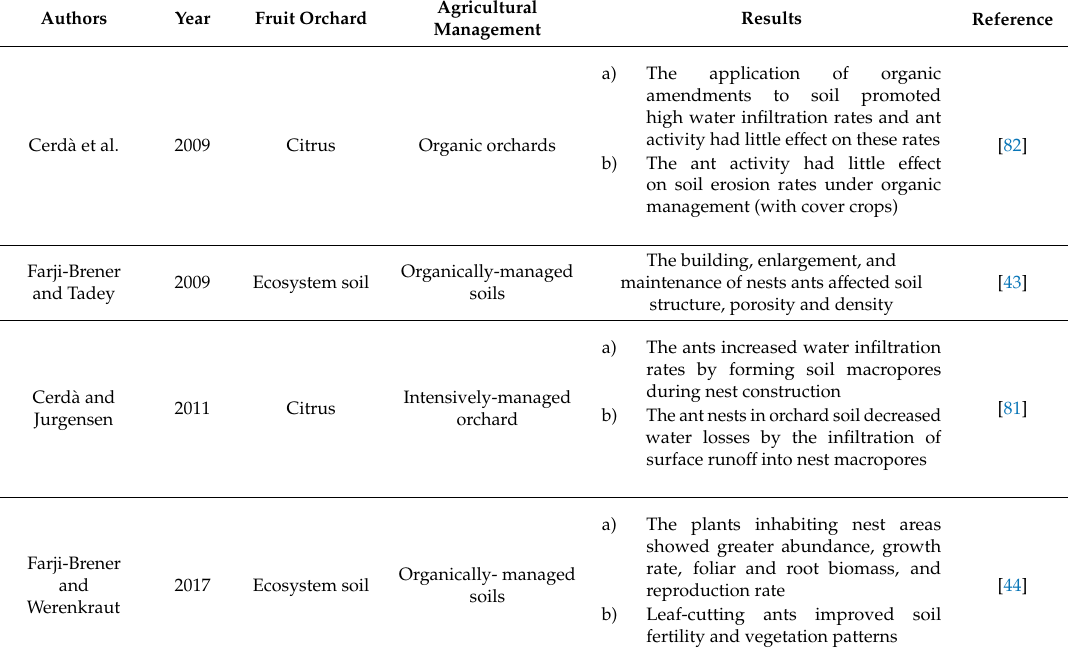
Table 2. E ff ects of di ff erential agricultural management on ant dynamics in orchard